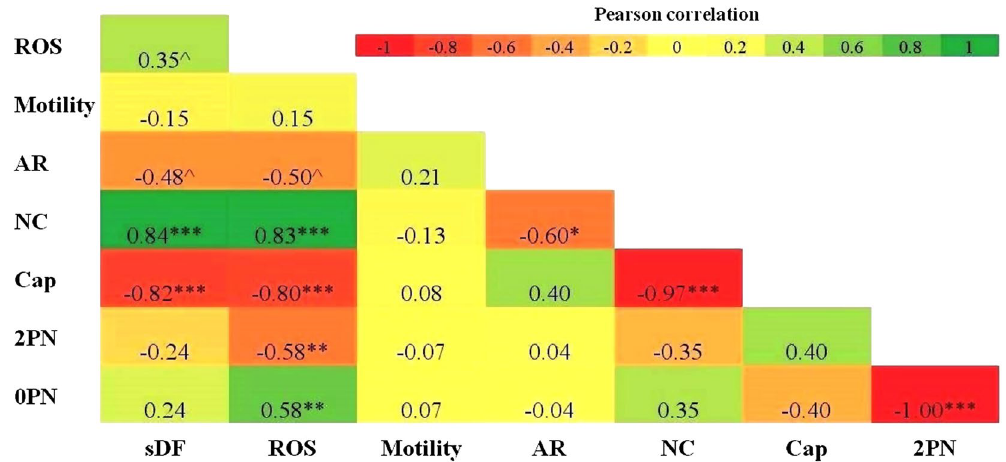
Figure 6. ( A ) Heatmap of pairwise correlations between variables. The Anderson–Darling test showed that data were normally distributed. Therefore, the Pearson correlation coefficient (as parametric correlation estimator) was used to assess the association between the two variables. The red and green boxes display negative and positive correlations, respectively. ROS reactive oxygen species, sDF sperm DNA fragmentation, NC non- capacitation, AR acrosome reaction, PN pronuclear, Cap capacitation, Motility progressive sperm motility. ^, *, **, and *** indicate P < 0.15, P < 0.05, P < 0.01, and P < 0.001, respectively. The scale bar shows the relationship between the